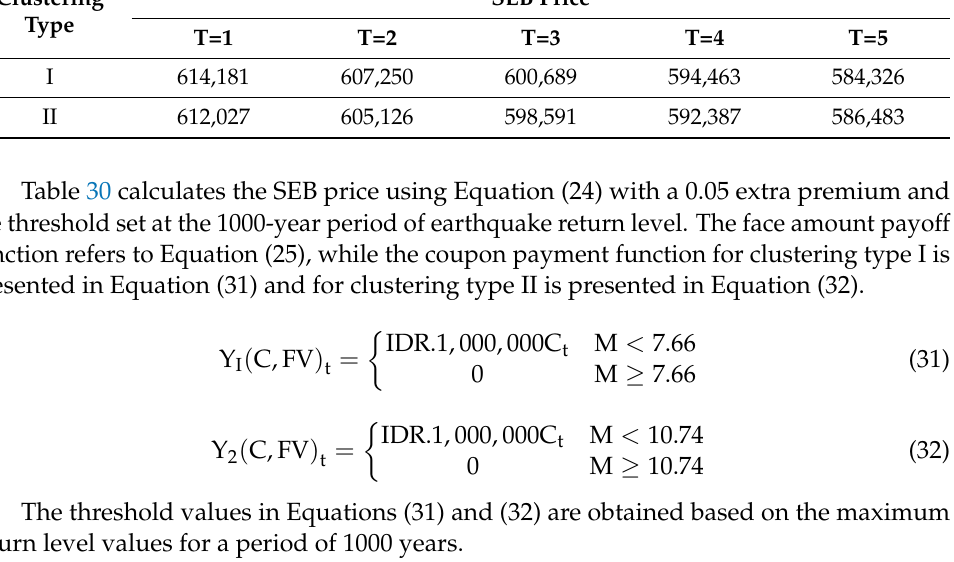
Table 30. SEB price at T = 1, 2, 3, 4, 5 years in the clustering type I and II (IDR).